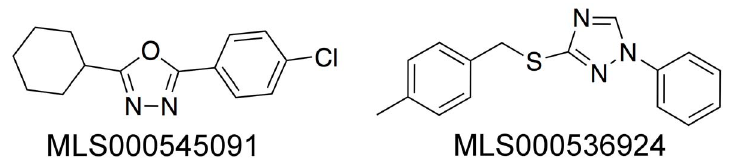
Figure 2. Discovered 15-LOX-2 Selective inhibitors.